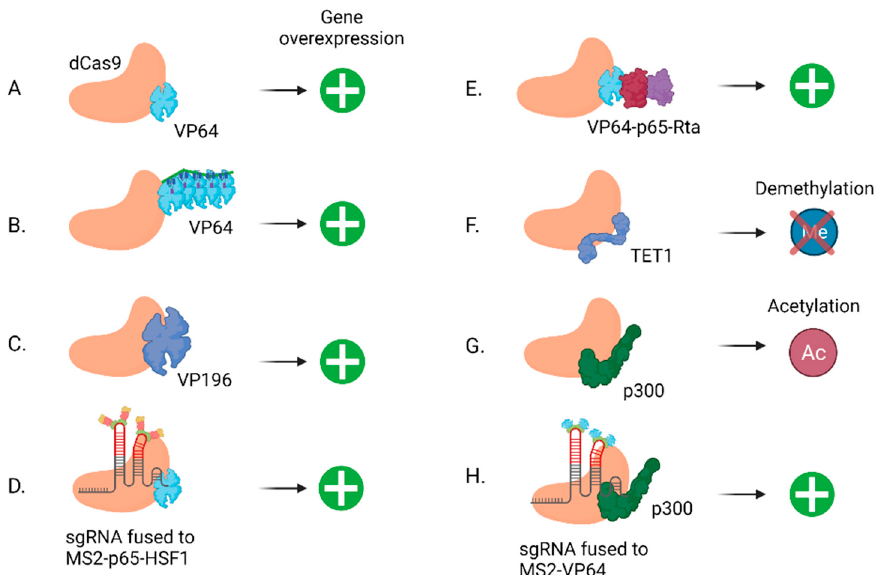
Figure 4. Different approaches for efficient gene activation using CRISPRa. ( A ) dCas9 fused to the VP64 viral repeat domain. ( B ) CRISPR SunTag, comprising multiple copies of VP64 fused to a protein scaffold and recruited to dCas9. ( C ) dCas9 fused to the VP196 viral repeat domain containing more repeats than VP64. ( D ) Synergistic activation mediator (SAM), comprising dCas9 fused to VP64 and a modified sgRNA fused to MS2, p65, and HSF1. ( E ) VPR, comprising dCas9 fused to VP64, p65, and Rta. ( F ) CRISPR-on, comprising dCas9 fused to TET1 to reverse the repressive methylation effect caused by CRISPR-off (See Section 2.2 and Figure 3G above). ( G ) dCas9 fused to p300 leading to H3K27 acetylation for gene transactivation. ( H ) enCRISPRa, comprising dCas9 fused to p300 and a modified sgRNA fused to MS2 and VP64. (Created with BioRender.com (accessed on 12 December 2021)).